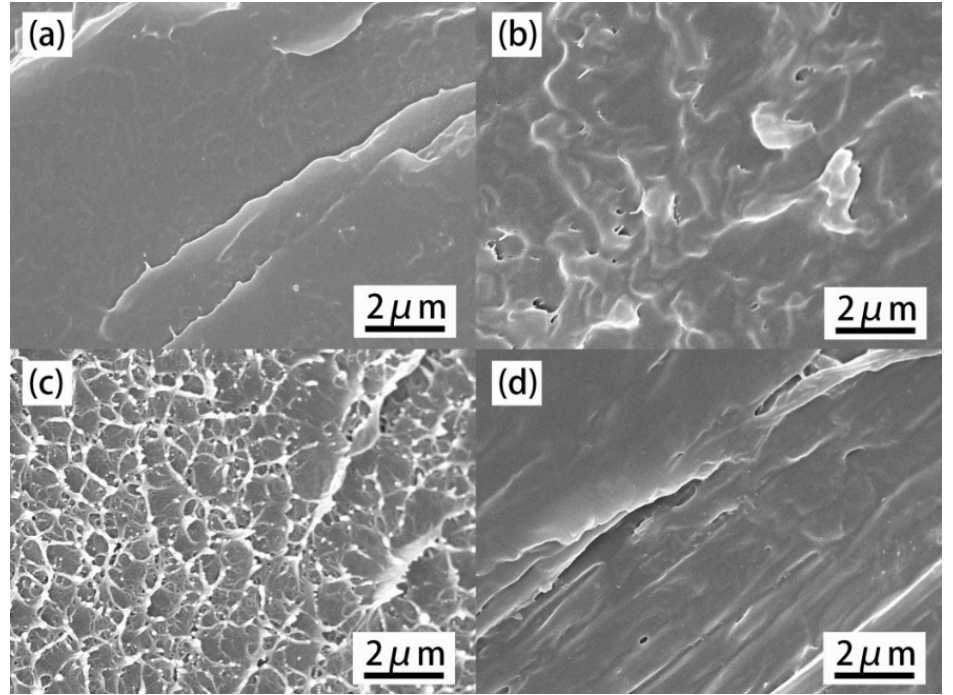
Figure 5. SEM images of neat PET and its composites’ fracture surfaces. ( a ) PET, ( b ) PET-0.4G, ( c ) PET-0.2H, ( d ) PET-0.4G-0.2H.